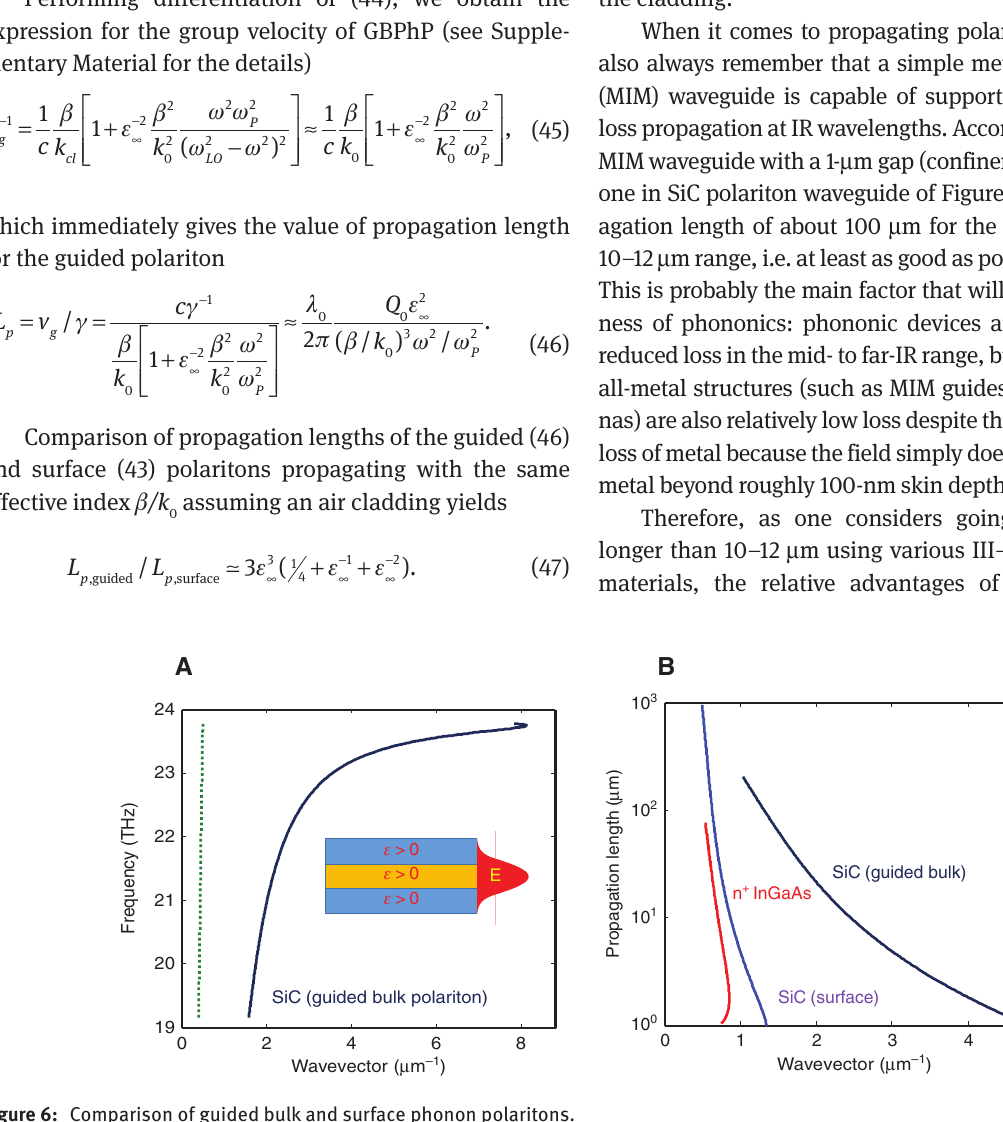
Figure 6: Comparison of guided bulk and surface phonon polaritons. (A) Dispersion of guided bulk phonon polariton in SiC shown in the inset. The dashed line represents the light line in the cladding. (B) Propagating lengths vs. wavevector of the guided polariton compared with the surface phonon polariton and surface